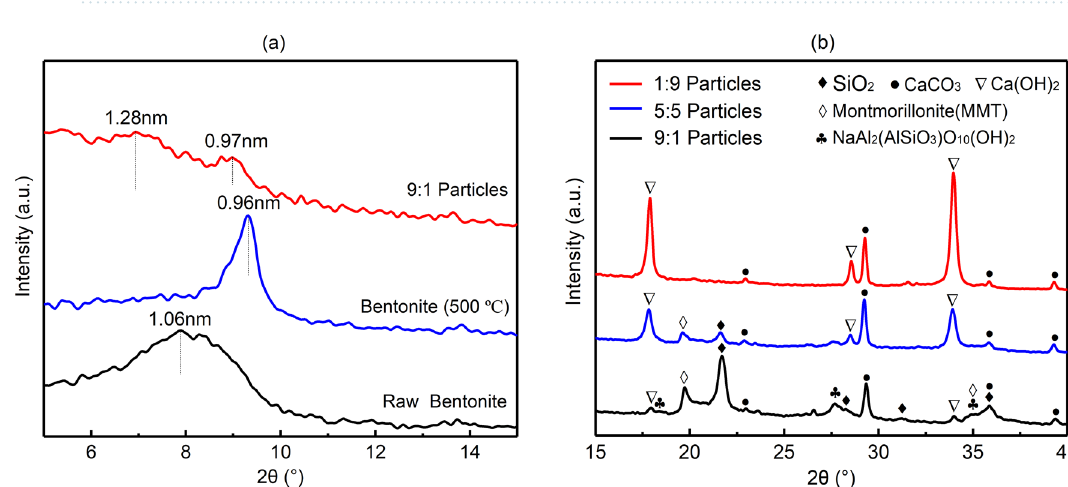
Figure 3. XRD diffraction data: ( a ) uncalcined bentonite, bentonite calcined at 500 °C and 9:1 particles, ( b ) 9:1 particles, 5:5 particles and 1:9